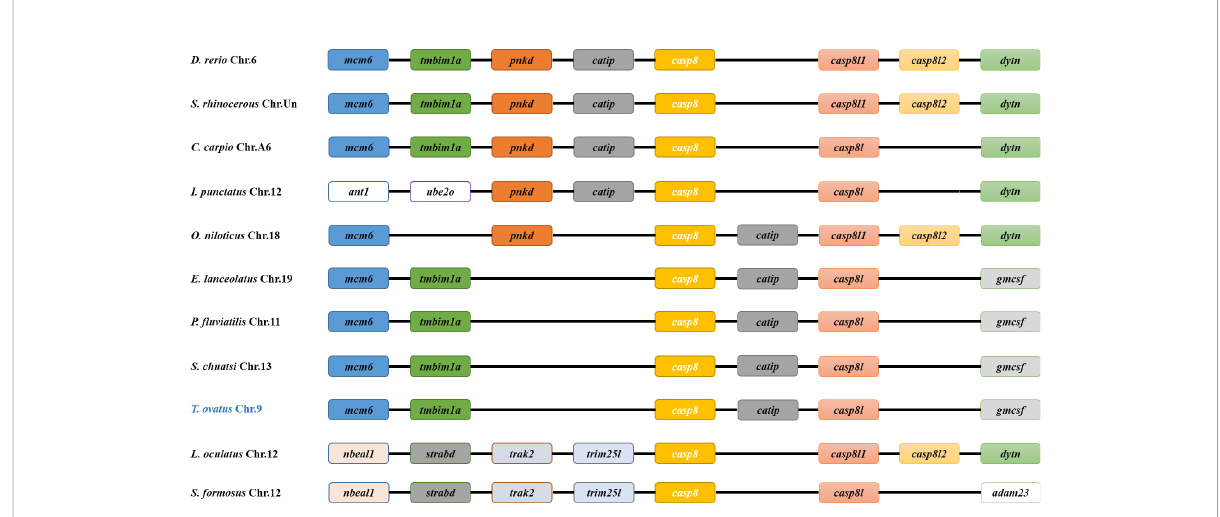
FIGURE 3 Phylogenetic analysis of Cas8 and other Caspase family members based on the alignment of amino acid sequences using MEGA 6. The tree was deduced by the neighbor-joining method, based on 1000 bootstrap replications for bootstrap analysis.